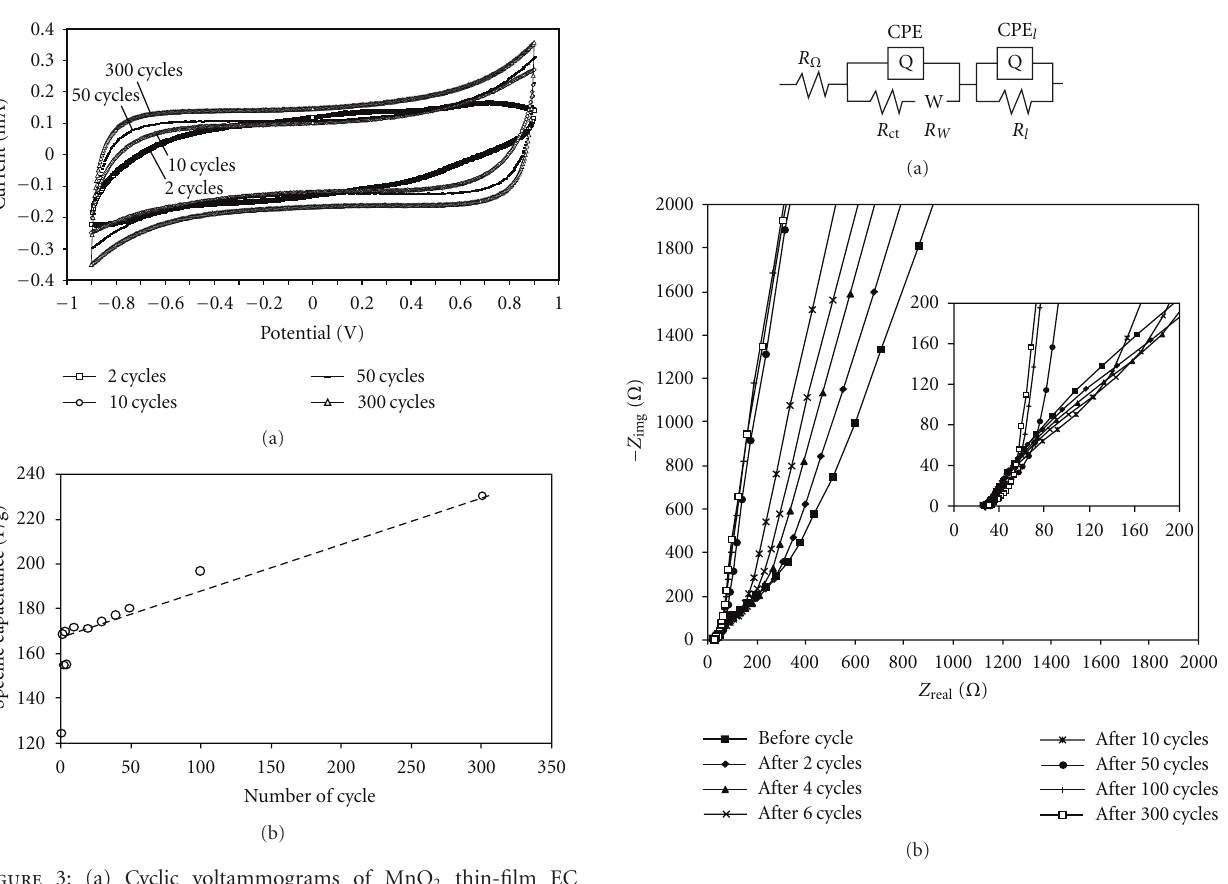
Figure 4: (a) Equivalent circuit model of MnO 2 thin-film EC prototypes, (b) impedance plots of electrochemical capacitors (EC) at di ff erent charge/discharge cycle (inset shows the high-frequency regions of impedance plots).